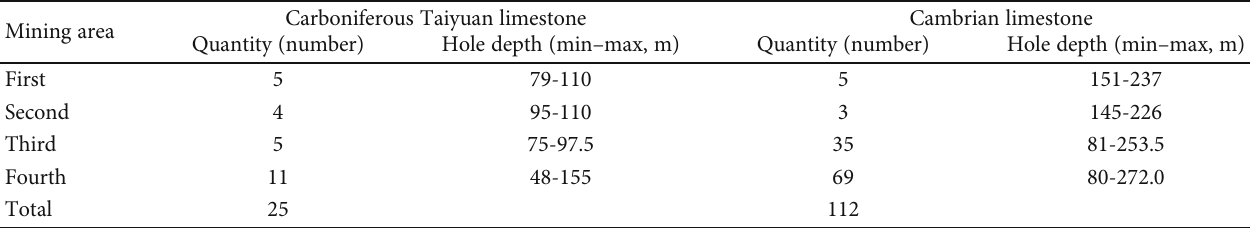
Table 2: The number and depth of hydrogeological boreholes in mining areas.